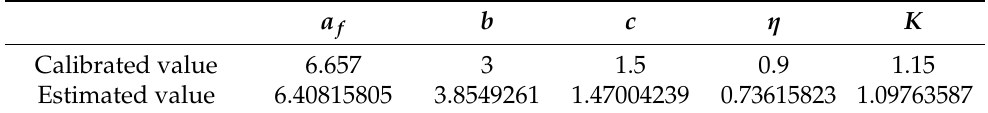
Figure 10. Experimental data—Temperatures above 400 ◦ C. Table 6. Posterior estimation of the unknown parameters θ obtained from infrared experimental data.